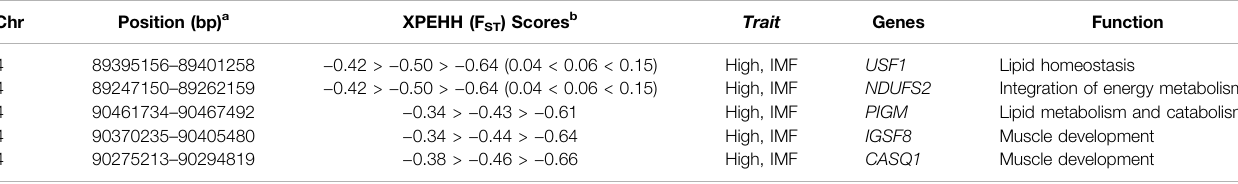
TABLE 2 | The annotation of seven potential candidate genes in SSC4 (Kim et al., 2015). Chr Position (bp) a XPEHH (F ST ) Scores